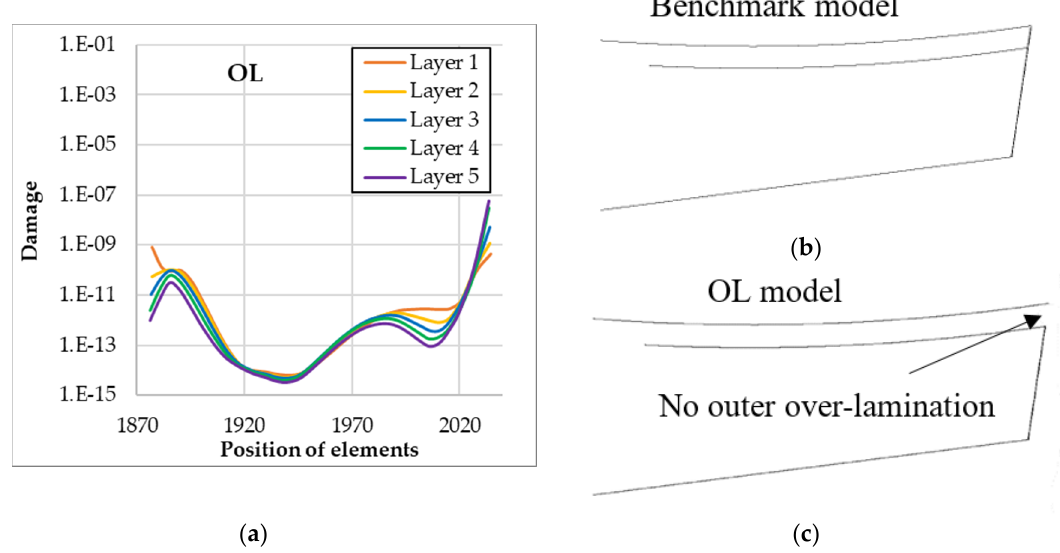
Figure 21. Damage of OL models and the difference between the two models: ( a ) Outer over-lamination in the benchmark model; ( b ) No outer over-lamination in the benchmark model.